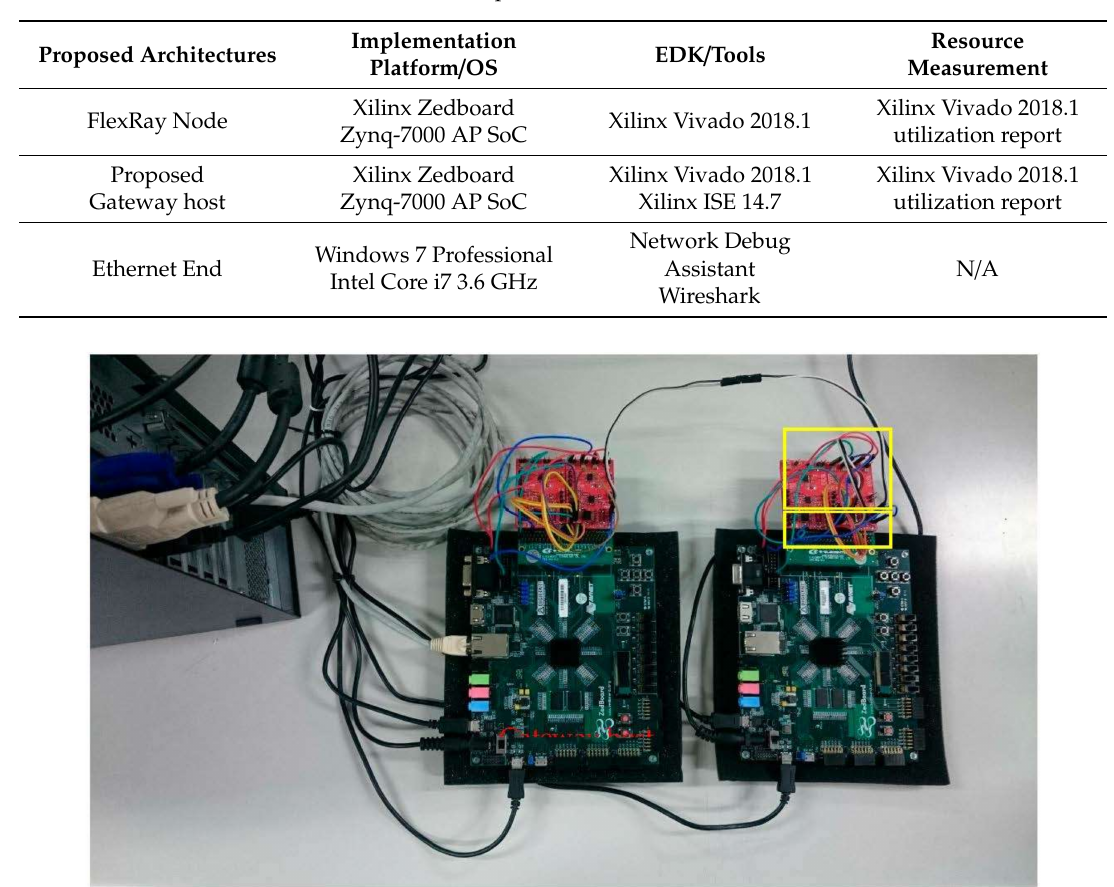
Table 4. Experimental environment.